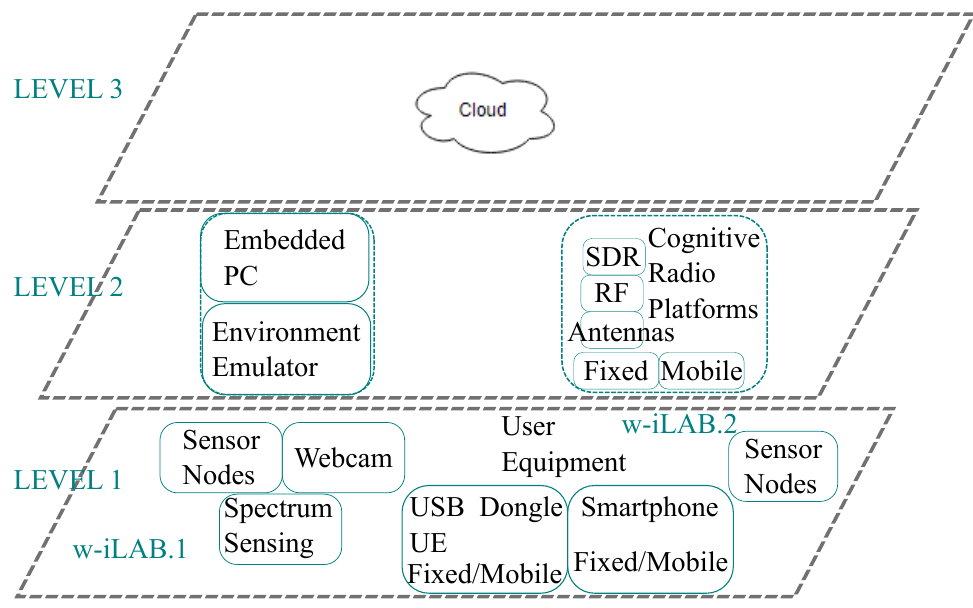
Figure 2. Overview of W-iLab1.t and